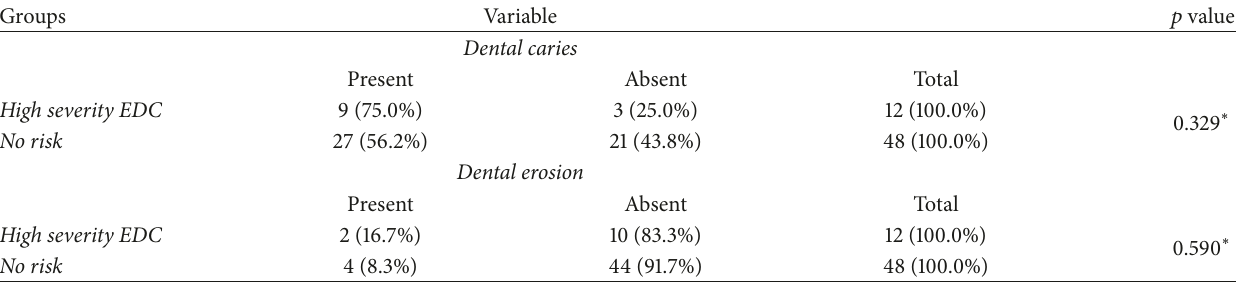
Table 3: Statistical significance and prevalence of dental erosion and caries ( 𝑛 = 60 ).